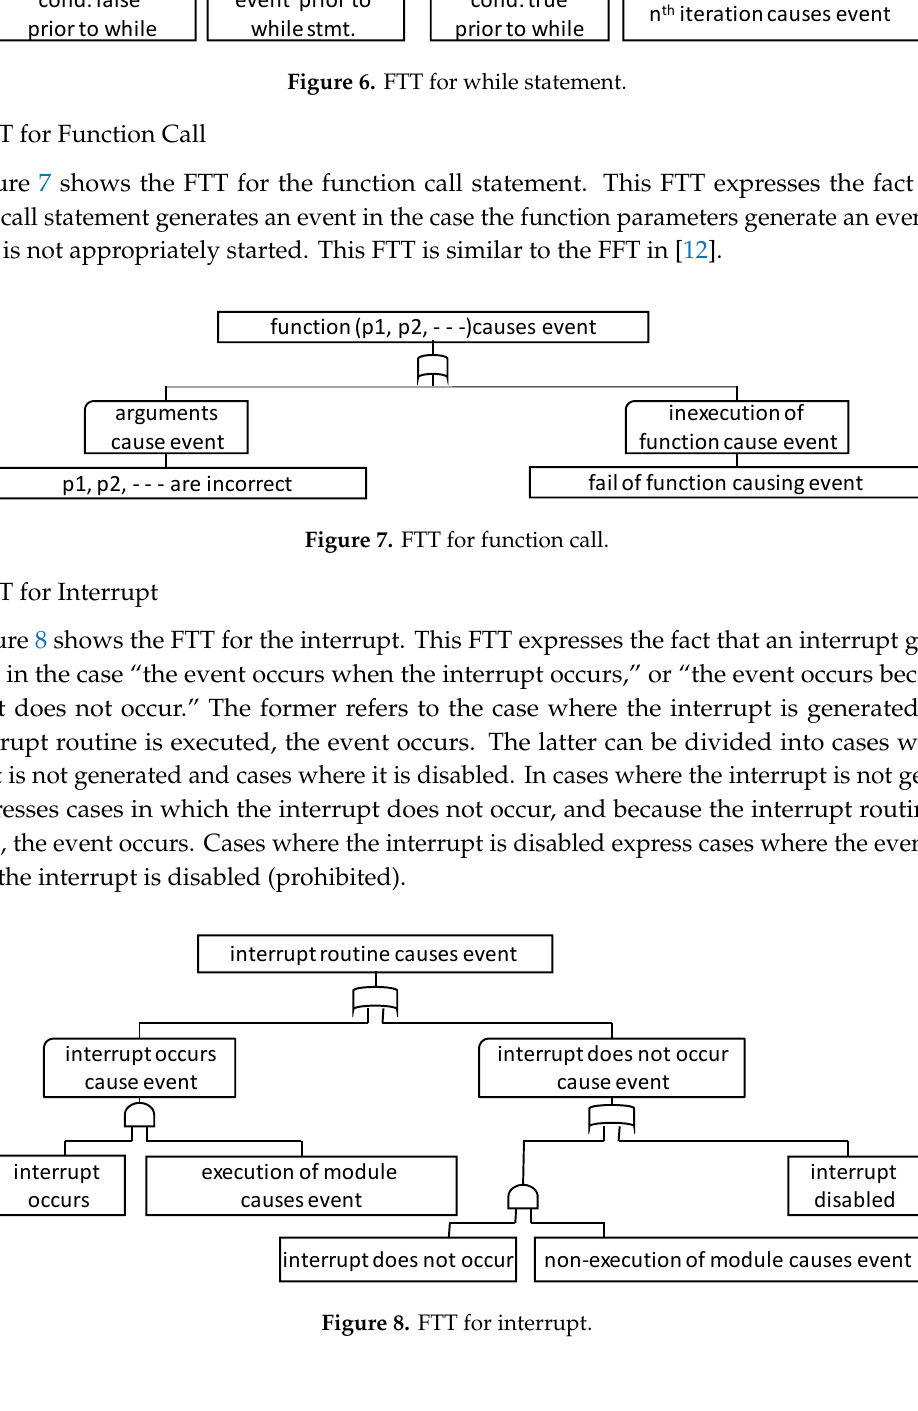
Figure 9. FTT for global variables. 3.2.7. FTT for Local Variables Figure 10 shows the FTT for the local variables. Local variables exist within the relevant variable scope (instruction, function, etc.). This FTT expresses the fact that local variables cause events when there is a relationship with an instruction in which the local variable is set in the value immediately before. Figure 10. FTT for local variables. 3.2.8. FTT for Array Figure 11 shows the FTT for an array. This FTT expresses the fact that “index of the array becomes less than 0,” “the array causes the event when the N-th element does not exist (out of range, illegal index access),” or “the value stored in the N-th element is inappropriate.”